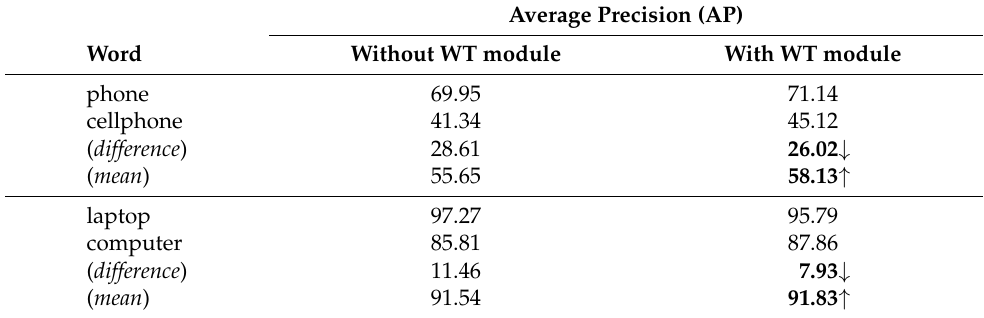
Table 3. The effect on the Average Precisions (APs) of synonyms (“phone” and “cellphone”, “laptop” and “computer”) by the WT module. The difference is calculated by subtracting the APs of two synonymous words; the lower ↓ , the better. The mean is the mean value of the APs of two synonymous words; the higher ↑ , the